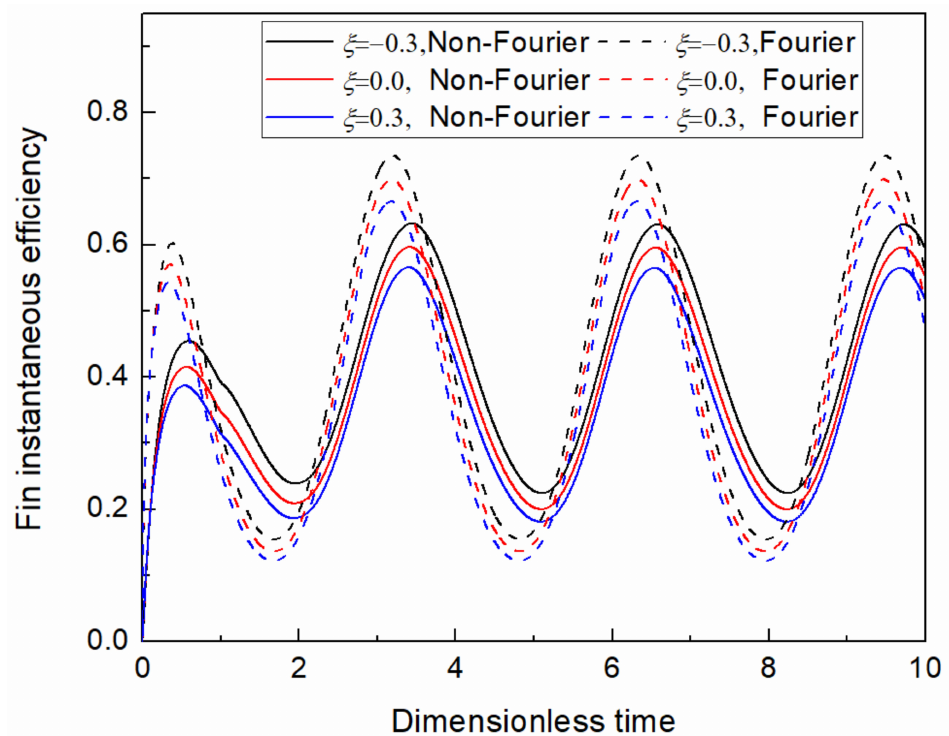
Figure 14. The variation of instantaneous fin efficiency at different values of ξ